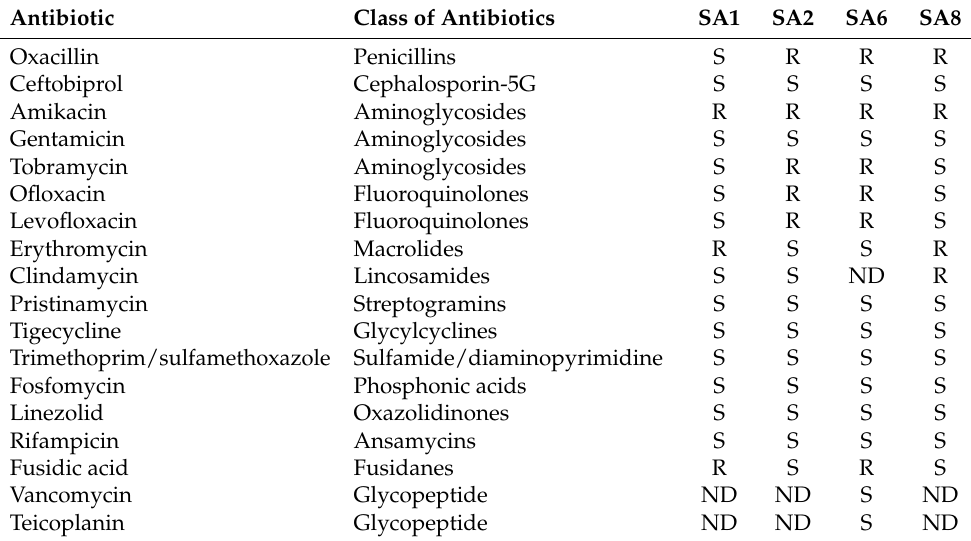
Table A1. Antibiograms of the four Staphylococcus aureus multidrug resistant strains.